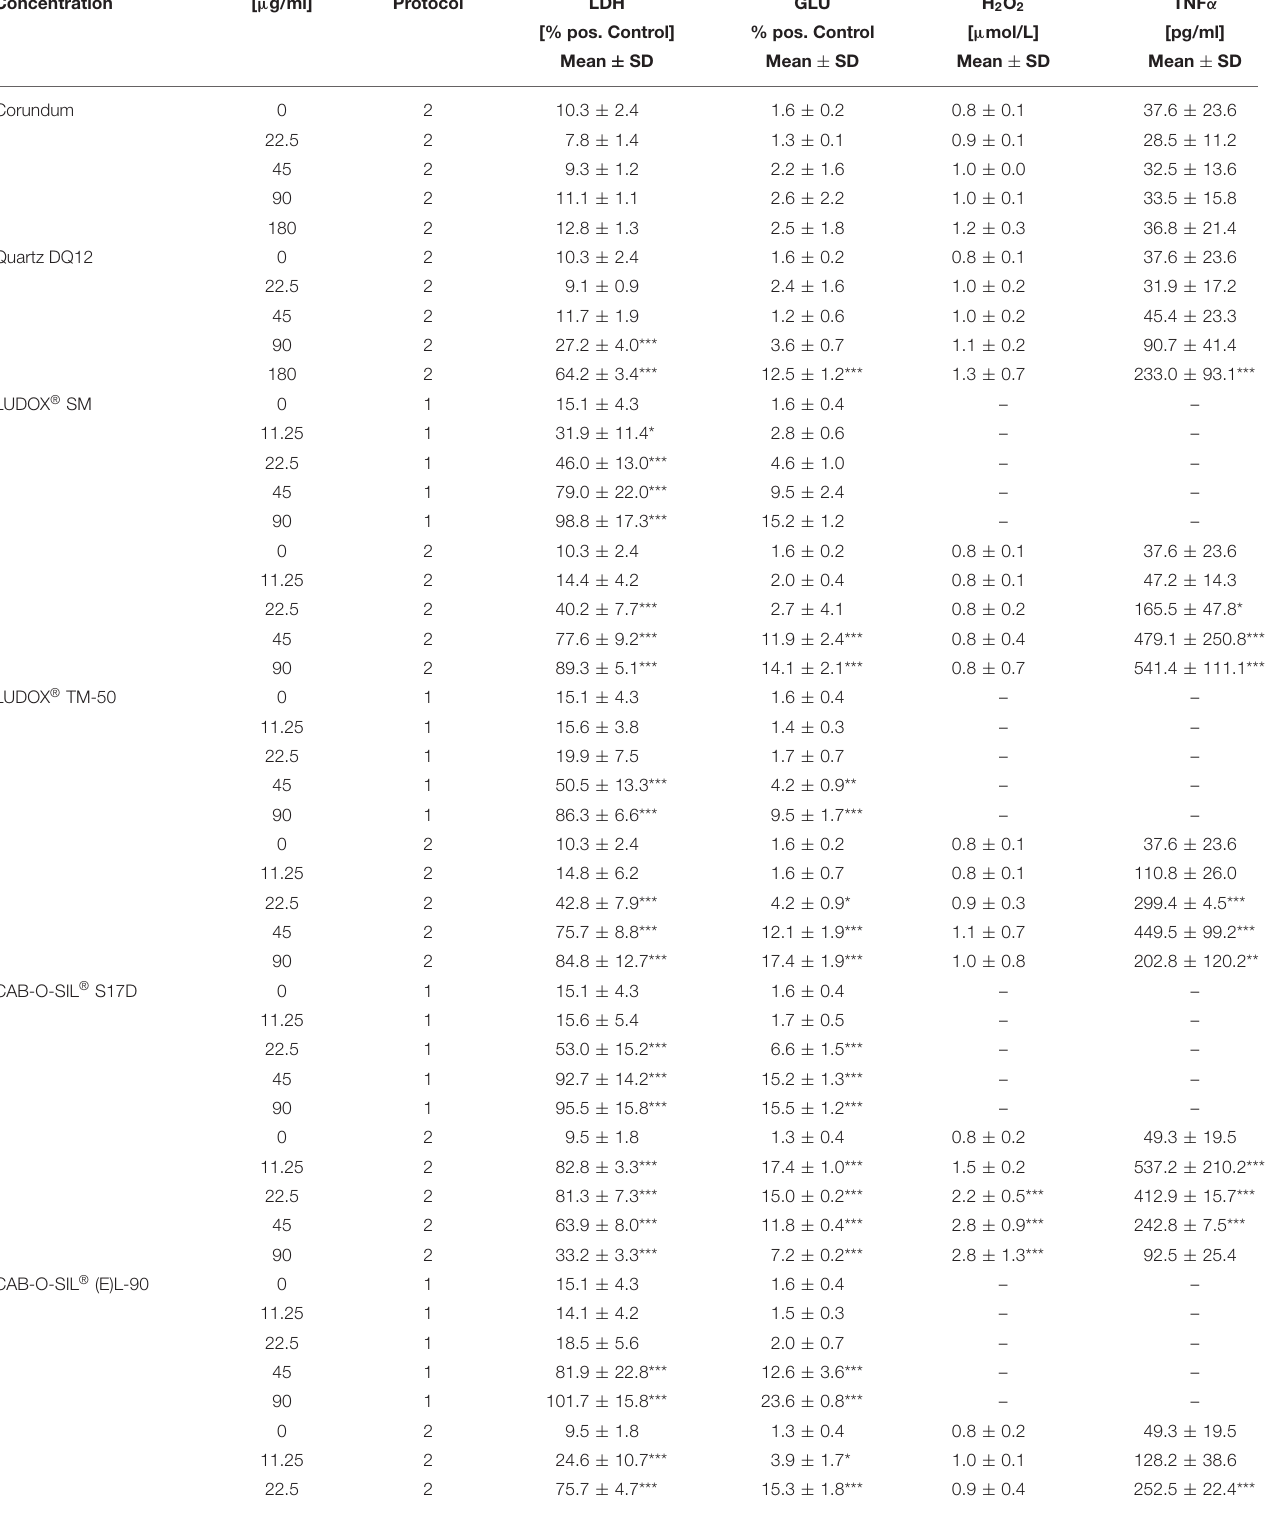
TABLE 3 | Effects of non-treated SAS dispersed with Protocol 1 and 2 on NR8383 cells.